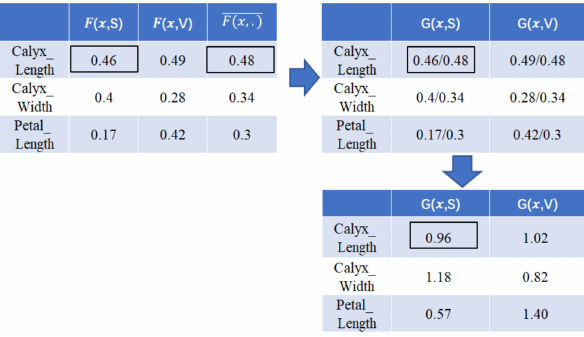
Figure 3. Principle of computation of contrast for selected